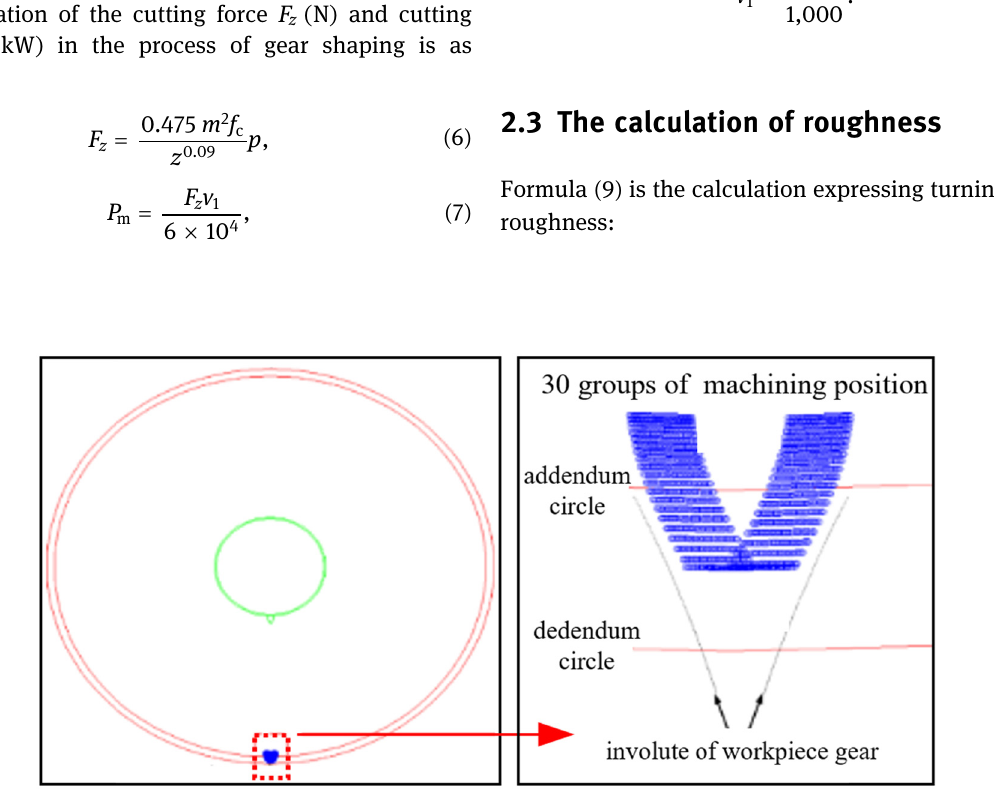
Figure 2: The machining position trajectory calculation by MATLAB.